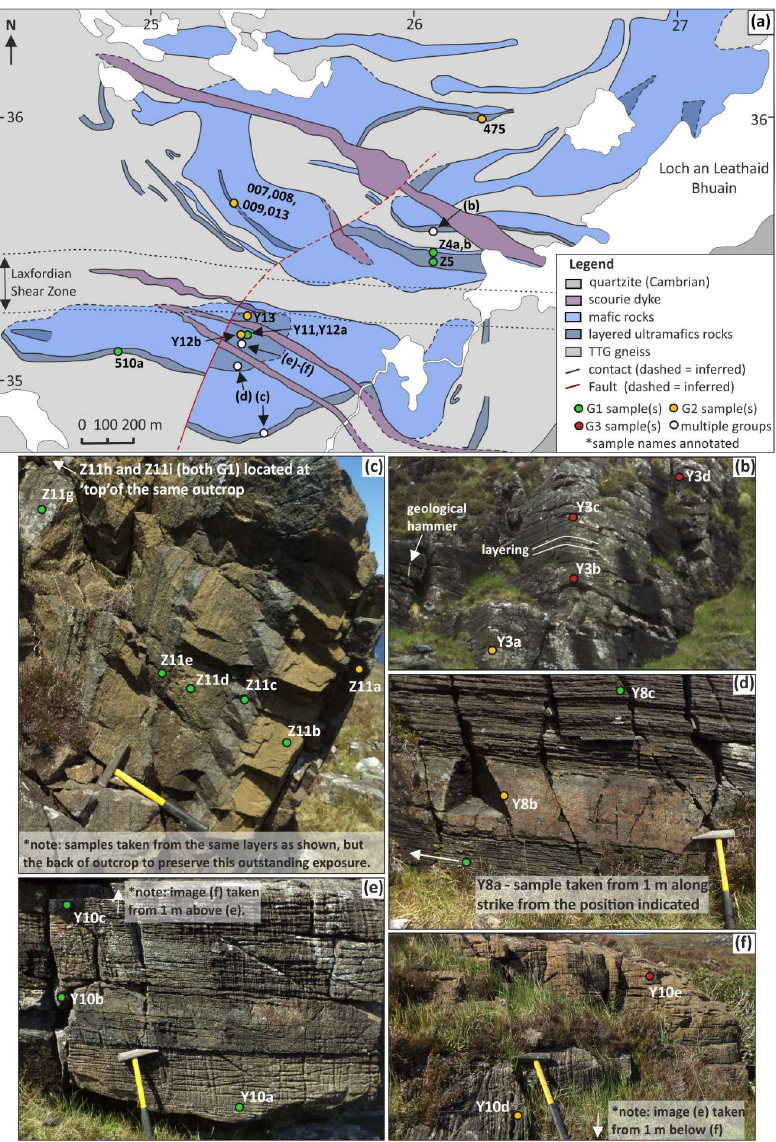
Figure 3. ( a ) Simplified geological map of the Ben Strome Complex detailing the locations of samples used in this study (modified after Guice et al. [45]). Structural measurements and stereonet plots